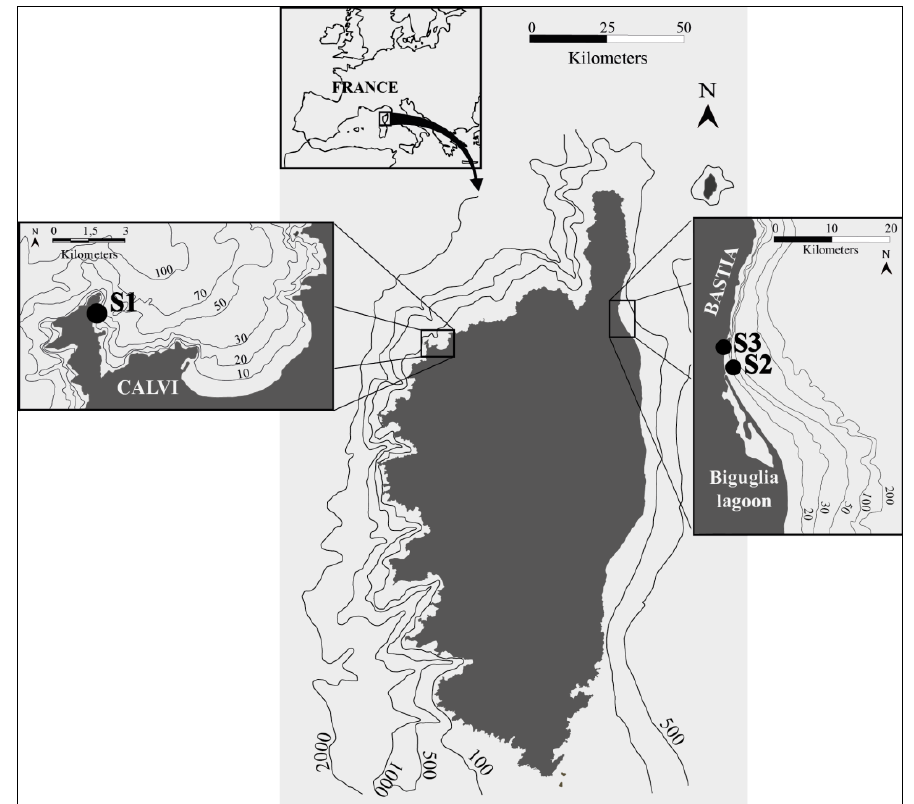
Figure 1. Location of Corsica Island, representation of the vertical asymmetry in bathymetric profile (according to French Navy’s Hydrographic and Oceanographic Department (SHOM) map, Western Mediterranean), and maps of the study areas giving station locations: S1, Bay of Calvi ; S2, littoral of Bastia, 1 km offshore and S3, littoral of Bastia, near the